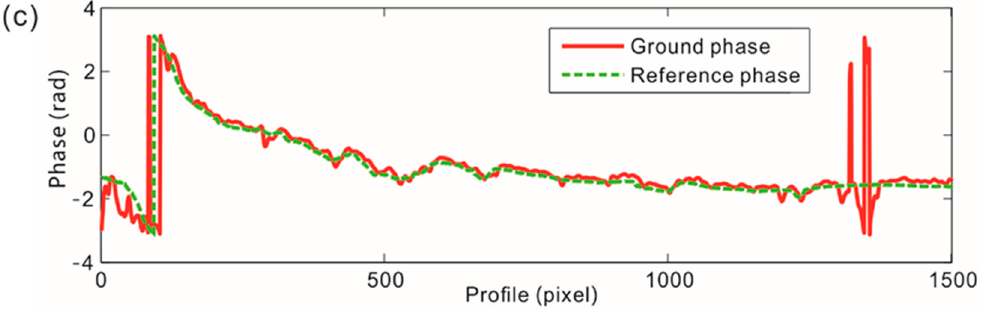
Figure 5. The ground phase ( a ); the reference phase ( b ) generated by LiDAR DEM and the phase profiles ( c ) of the black dashed lines in ( a ) and ( b ).